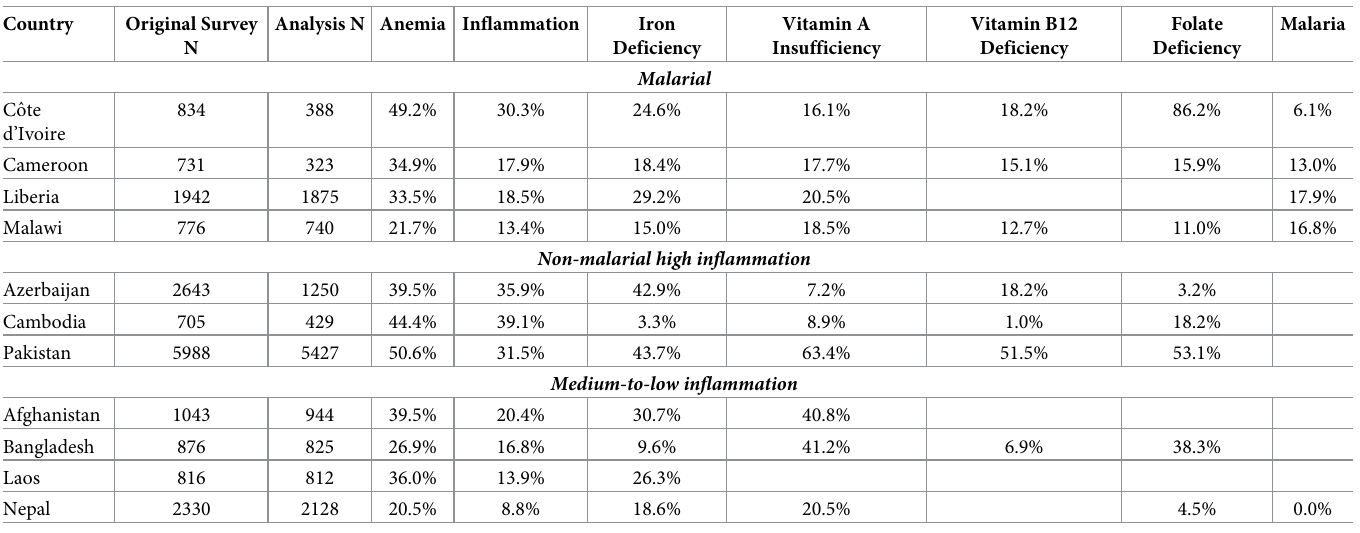
Table 2. Prevalence of anemia and selected anemia risk factors in women of reproductive age (WRA). Country Original Survey